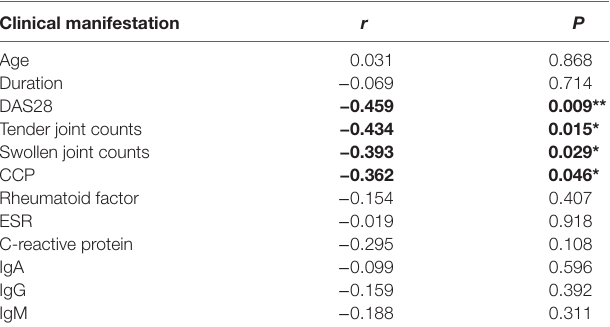
TaBle 2 | Correlation analysis of CD27 + IgD + B cells with rheumatoid arthritis patient clinical manifestations.